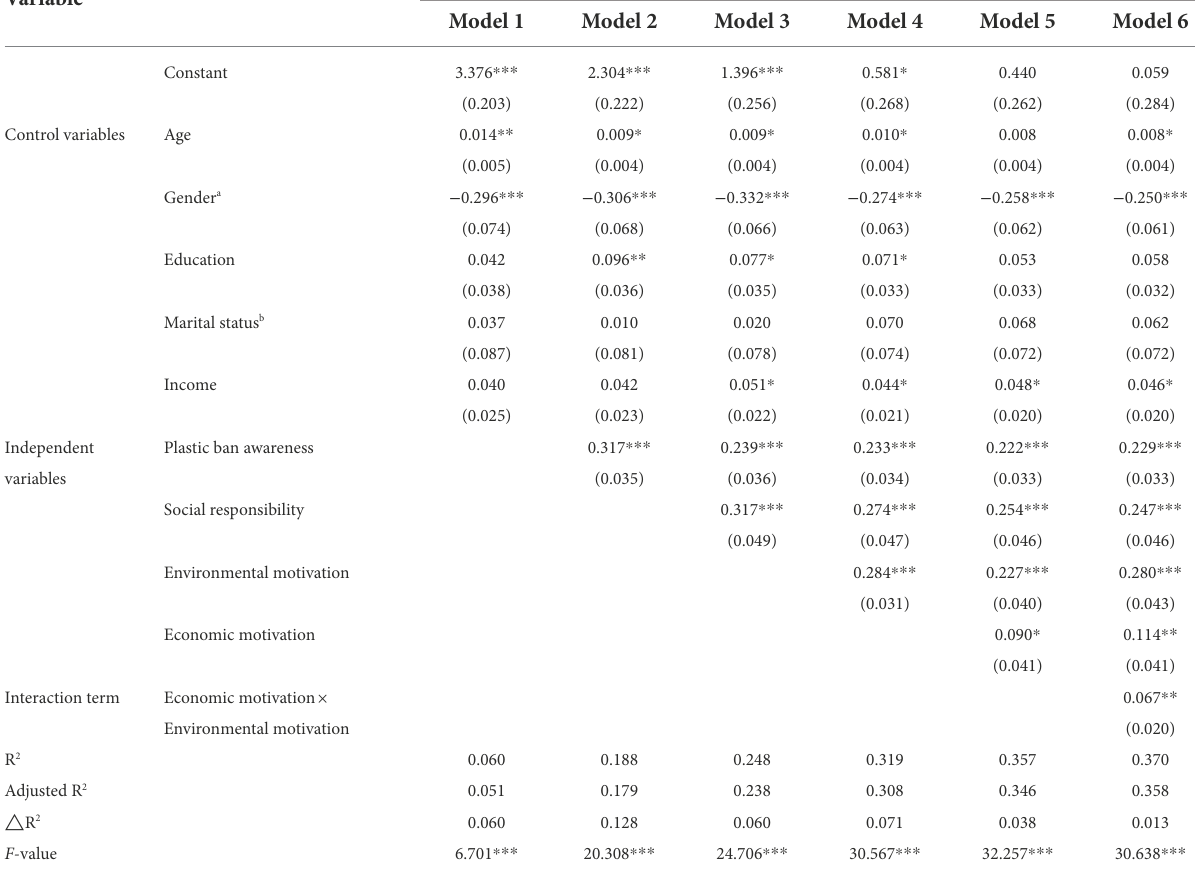
TABLE 2 OLS regression analysis for the relationships between influential factors and individuals’ intention to carry reusable bags for shopping.